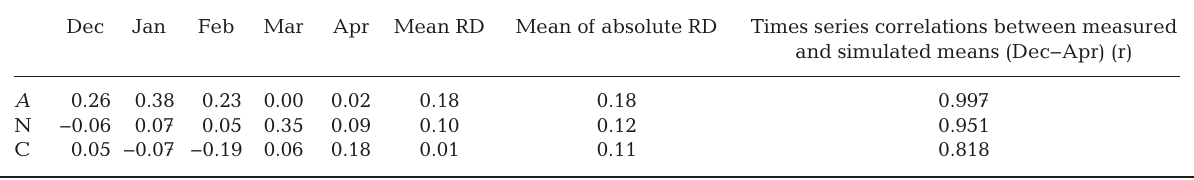
Table 4. Saccharina latissima . Relative differences [RD = (X simulated – X measured ) /X measured )] between simulated average (Simula- tion A, see Table 2) and measured average values of frond area (A) and nitrogen (N) and carbon (C) content (g g −1 ) on the sam- pling dates in the mesocosm experiment. Mean RD and mean absolute RD are also presented. Sample correlations (r) between the simulated and measured mean values are presented in the far right